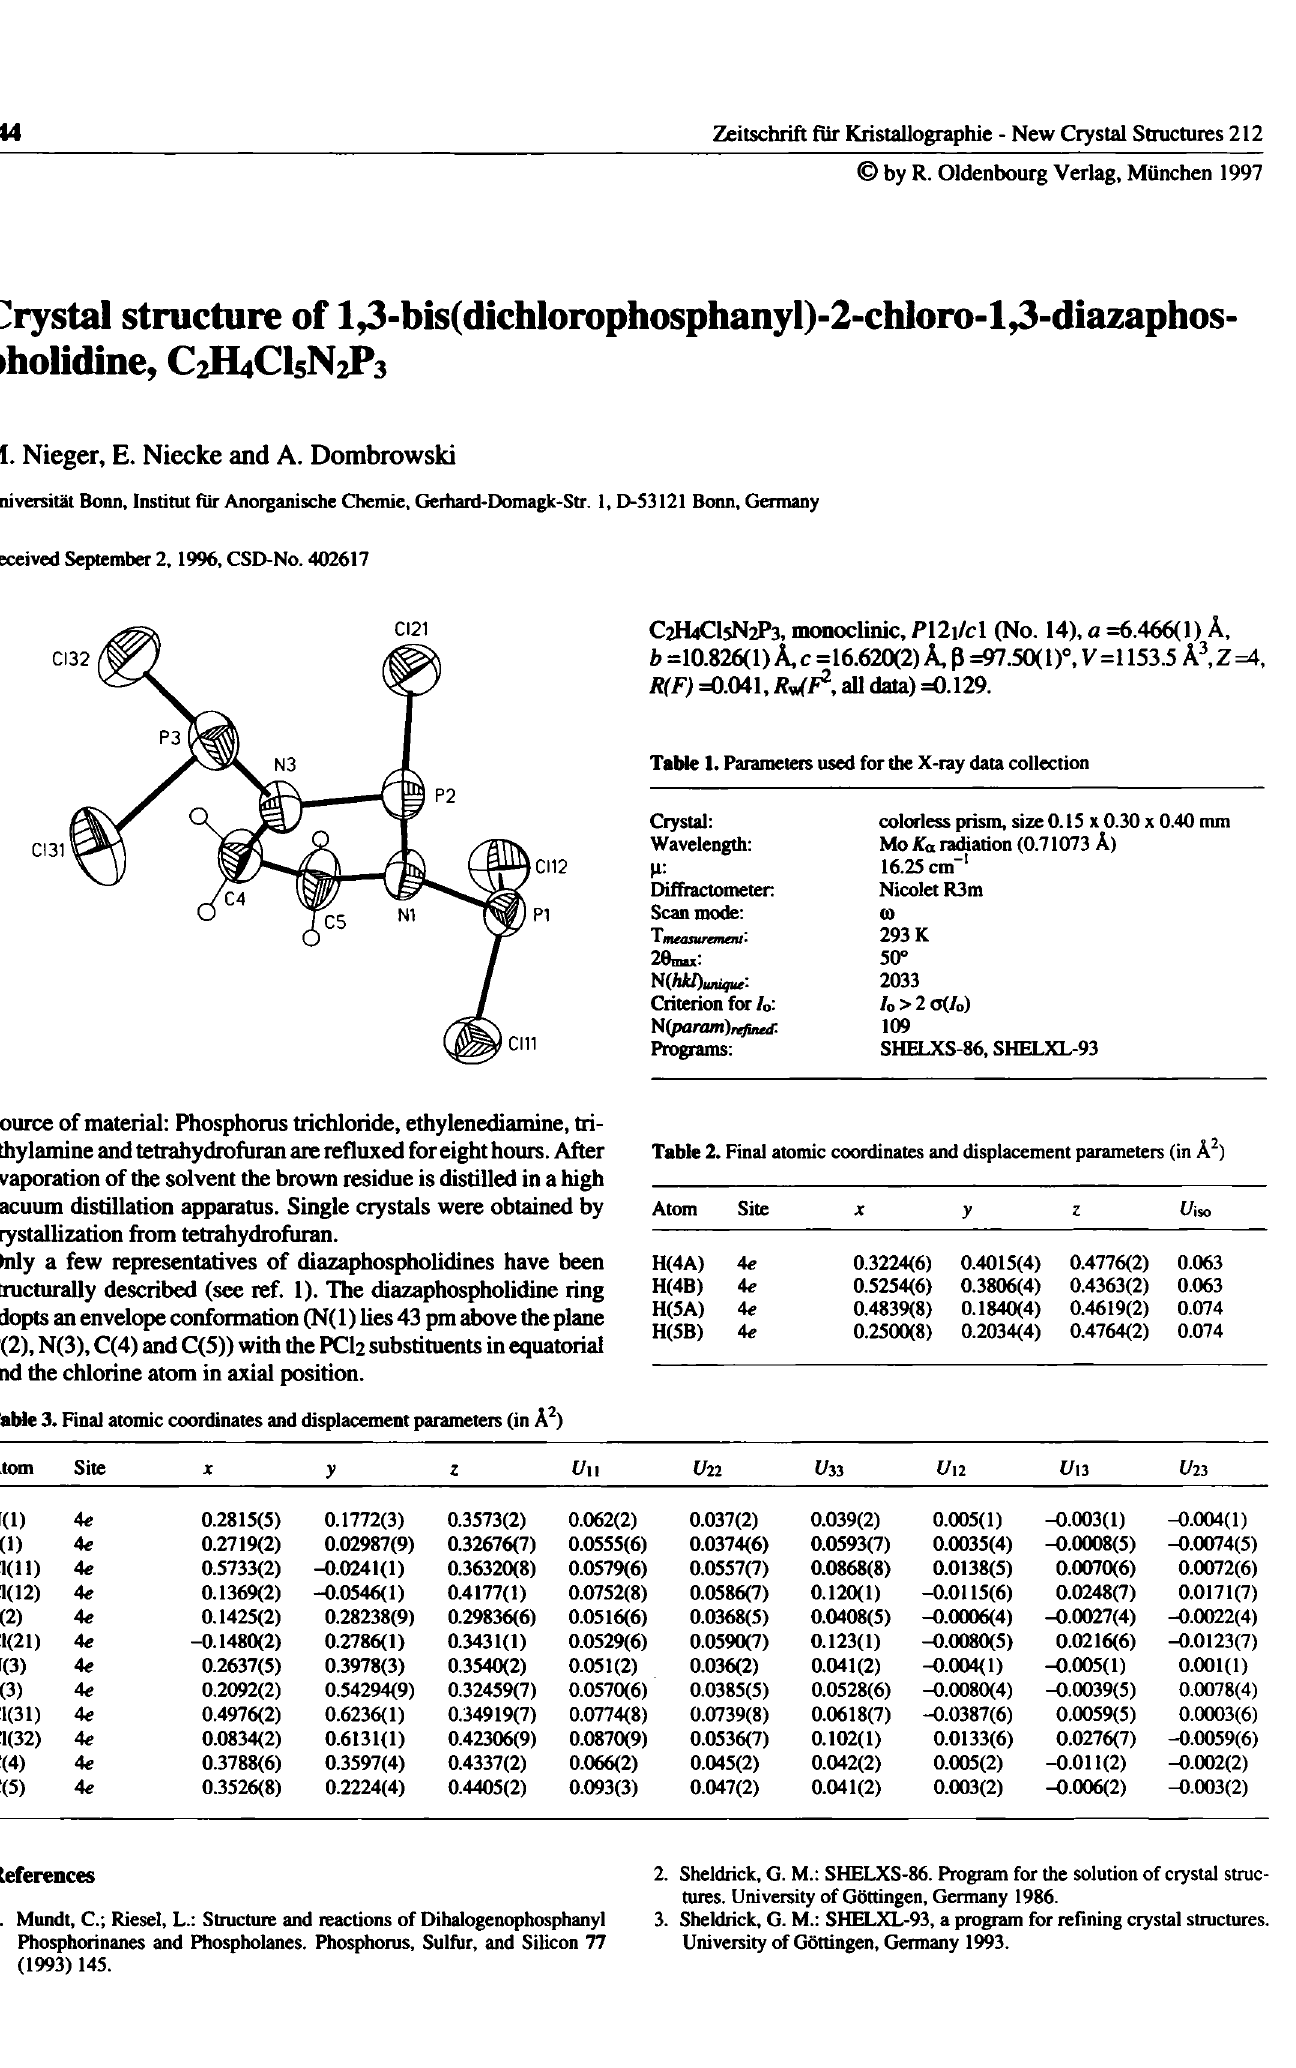
Table 3. Final atomic coordinates and displacement parameters (in Â 2 )